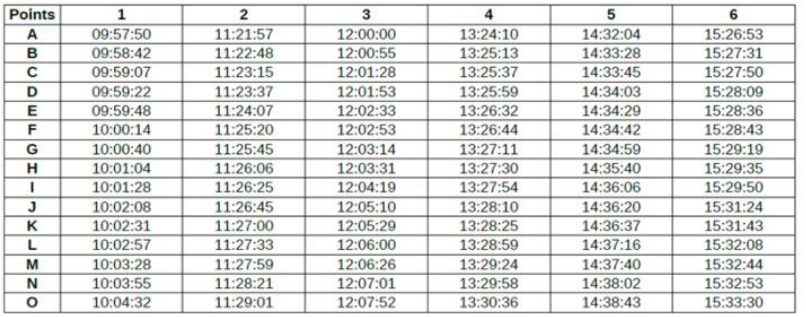
Figure 10. A screen capture of a typical “experiment file” from the departure service to an imaging service (all the data are time in the hh:mm:ss format).